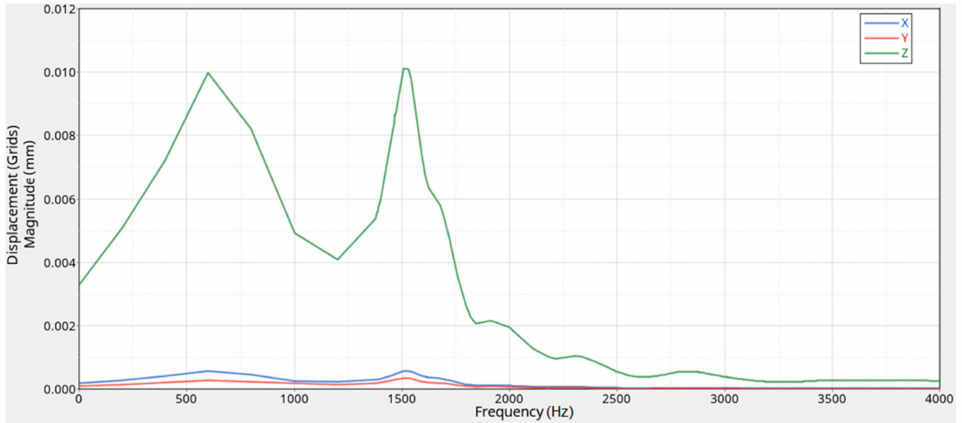
Figure 16. The displacement values of the rotor discs in the range of the analyzed